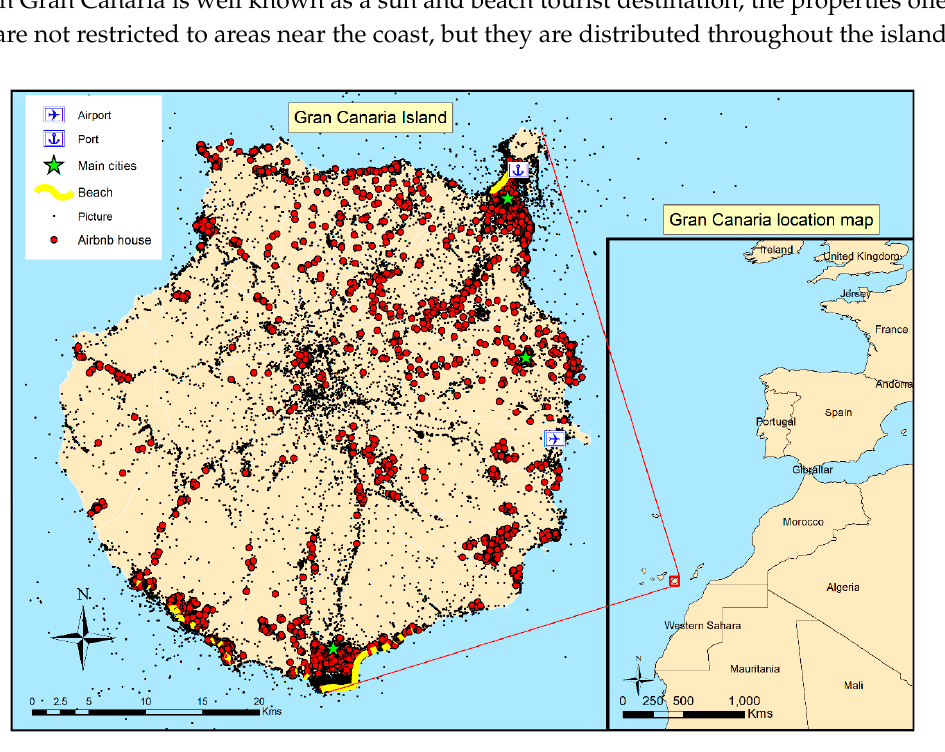
Figure 2. Gran Canaria Island scenario.